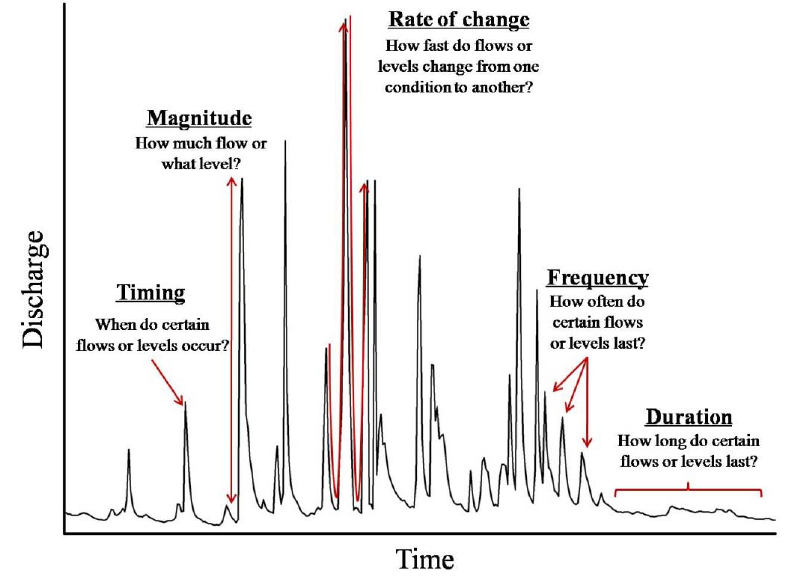
Figure 3. Quantified hydrologic regime using IHA method.